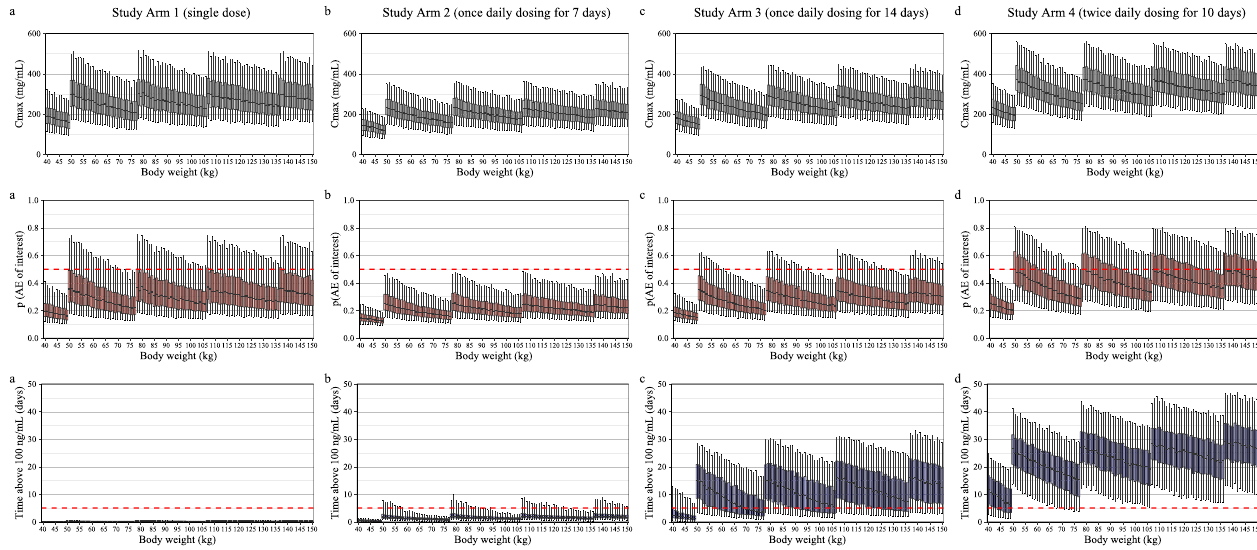
Fig 5. Simulations of emodepside exposure and probability of adverse events for study arm 1–4. Maximum emodepside plasma exposure (C max , upper panel), corresponding predicted probability of drug-related TEAE of interest (middle panel) and total time above the target concentration of 100 ng/mL (lower panel), stratified by body weight. The midline of the boxplots indicates the median, the box corresponds to the interquartile range, and the whiskers extend from the 5 th to the 95 th percentile. The red dotted line in the middle panel indicates a 50% probability threshold for any drug-related TEAE of interest. The red dotted line in the lower panel indicates the minimum number of days (5 days) above the target concentration. Simulations are based on administration of amorphous solid dispersion (ASD) tablet formulation B and the proposed body weight-based dosing regimen for a: study arm 1 (single dose of emodespide), b: study arm 2 (once daily dosing for 7 days), c: study arm 3 (once daily dosing for 14 days) and d: study arm 4 (twice daily dosing for 10 days) as described in Fig 4.